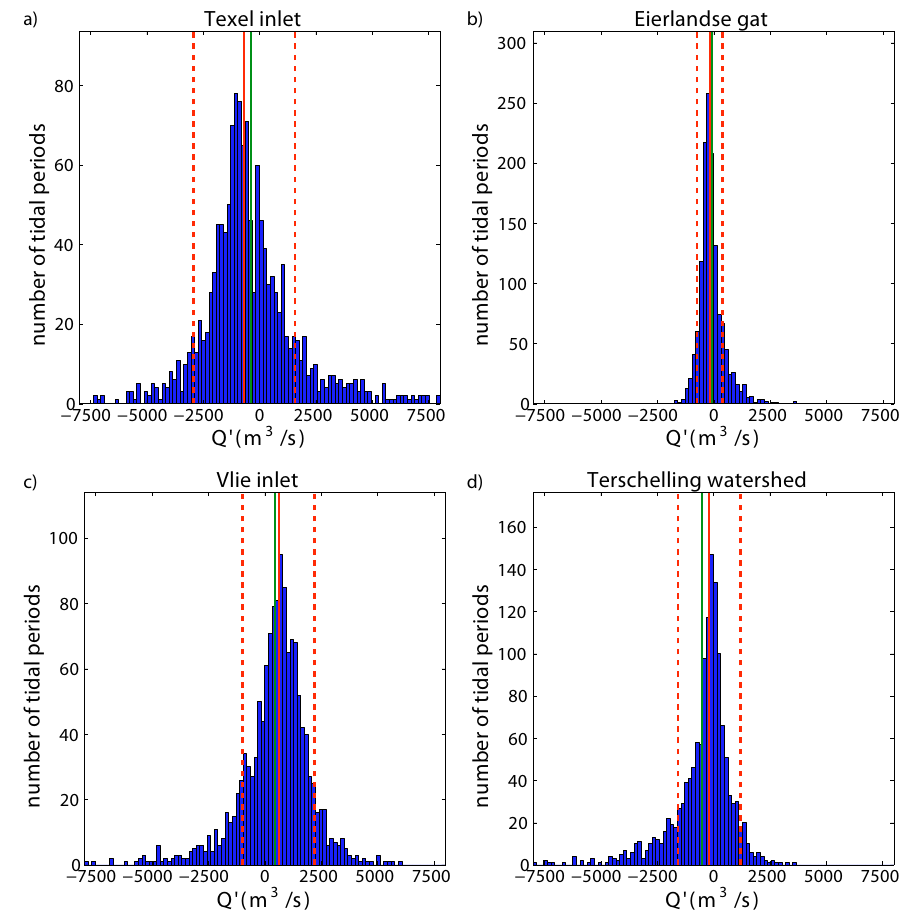
Figure 15. Histograms of the residual flow rate through the different inlets of the WDWS and the Terschelling watershed. The solid red line represents the median value, and the dashed lines represent the median value plus/minus one standard deviation. The green line represents mean value. Table 3. Median, standard deviation and skewness of the residual flow rate at the inlets of the WDWS and the Terschelling